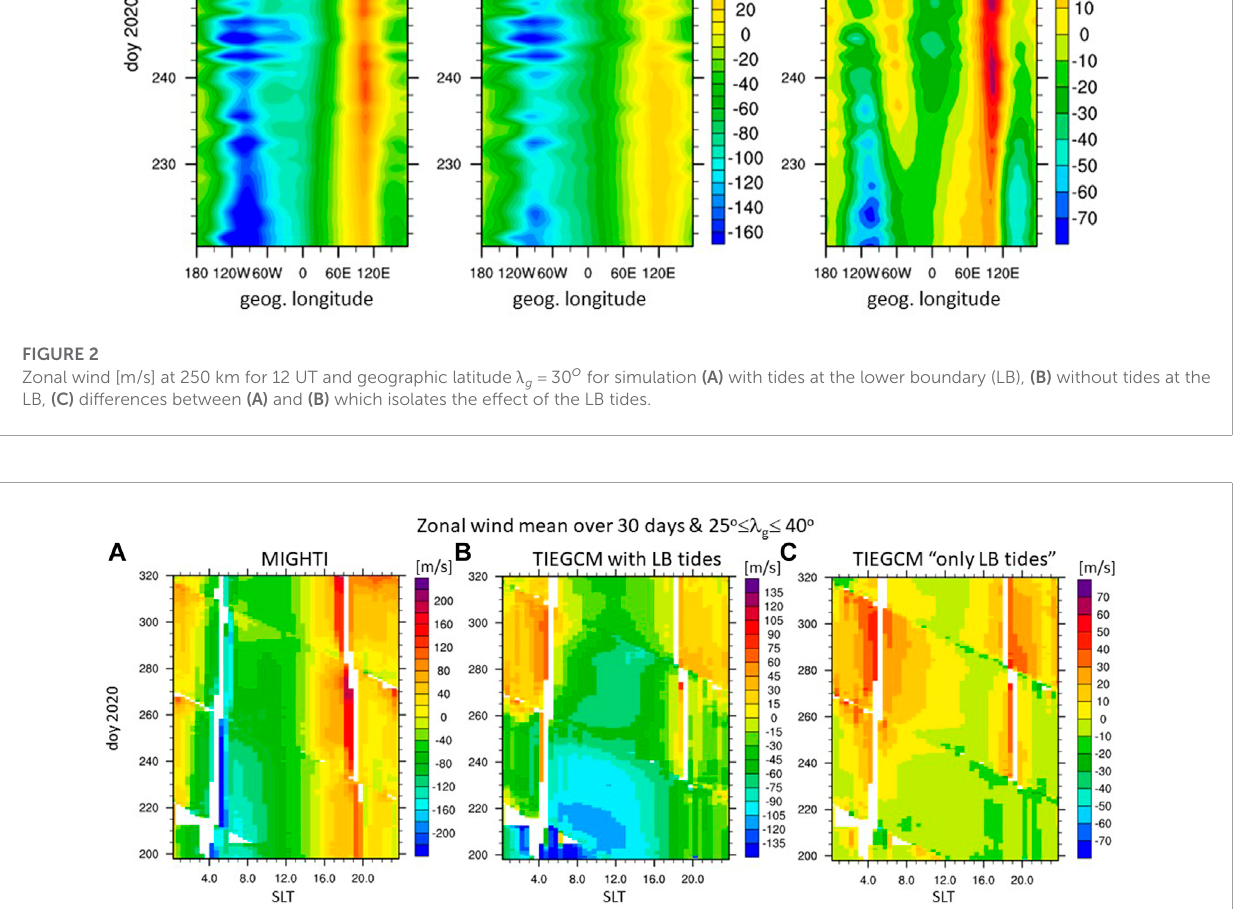
time around DOY 244 and 270 has a SymH <− 50 nT which is considered a moderate geomagnetic disturbed